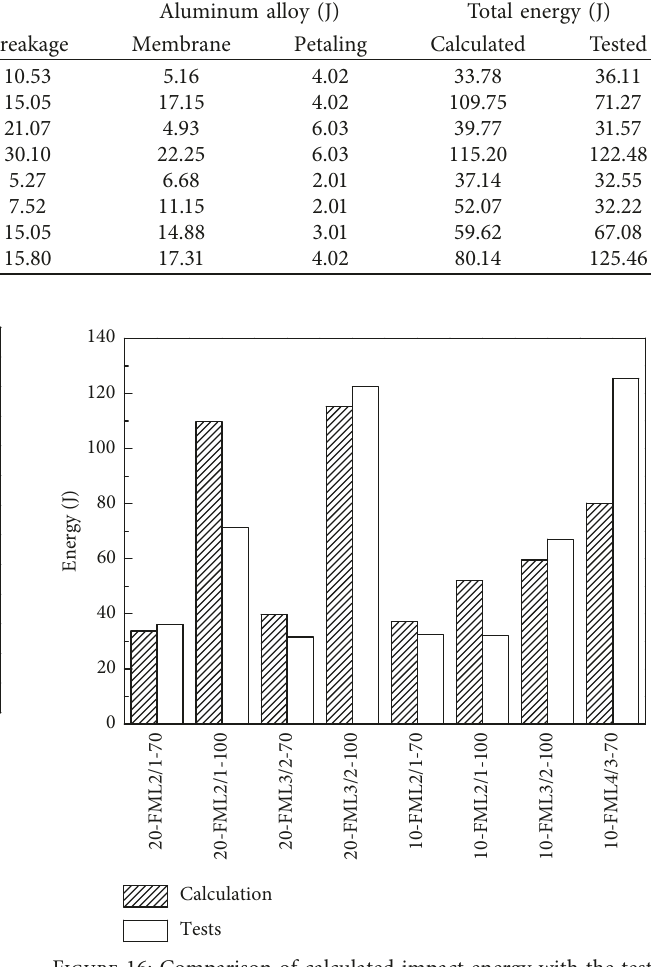
Figure 16: Comparison of calculated impact energy with the test results of BFML plates under drop-weight